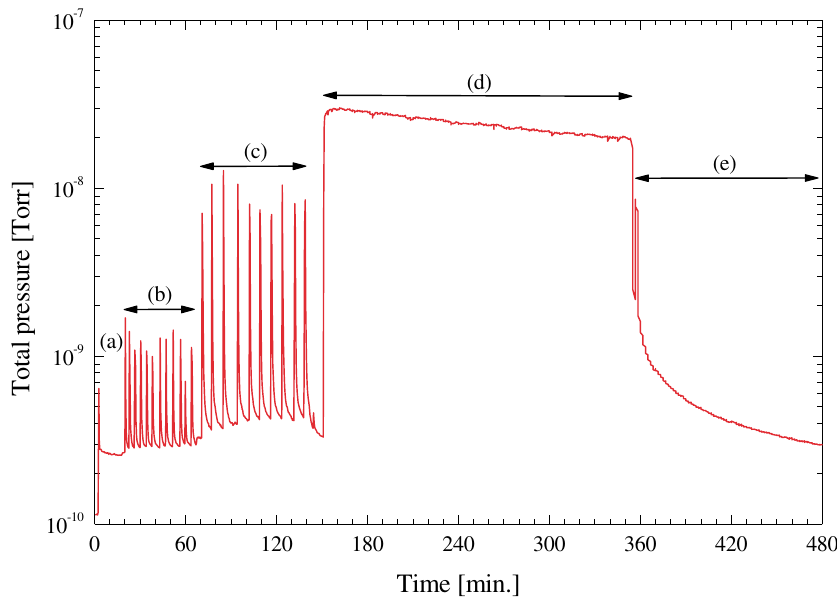
FIG. 4. (Color) Pressure in test chamber A during a period in the experiment. The particles impacted with 89.2 (cid:7) grazing incidence. (a) The sector valve separating the experimental line from LINAC 3 is opened. The pressure in LINAC 3 is higher than the base pressure in the experiment. (b) A series of single shots of 1 : 5 (cid:2) 10 9 Pb 53 (cid:1) ions. The time between the shots is the time needed for the vacuum to return to the conditions before each shot. (c) A series of single shots of 1 : 0 (cid:2) 10 10 Pb 27 (cid:1) ions. (d) Pb 53 (cid:1) shots are injected with a repetition rate of 1.2 s. (e) The ion beam was switched off, and the pressure decayed. The short pressure increase right after the beam was switched off arose when the sector valve was closed.